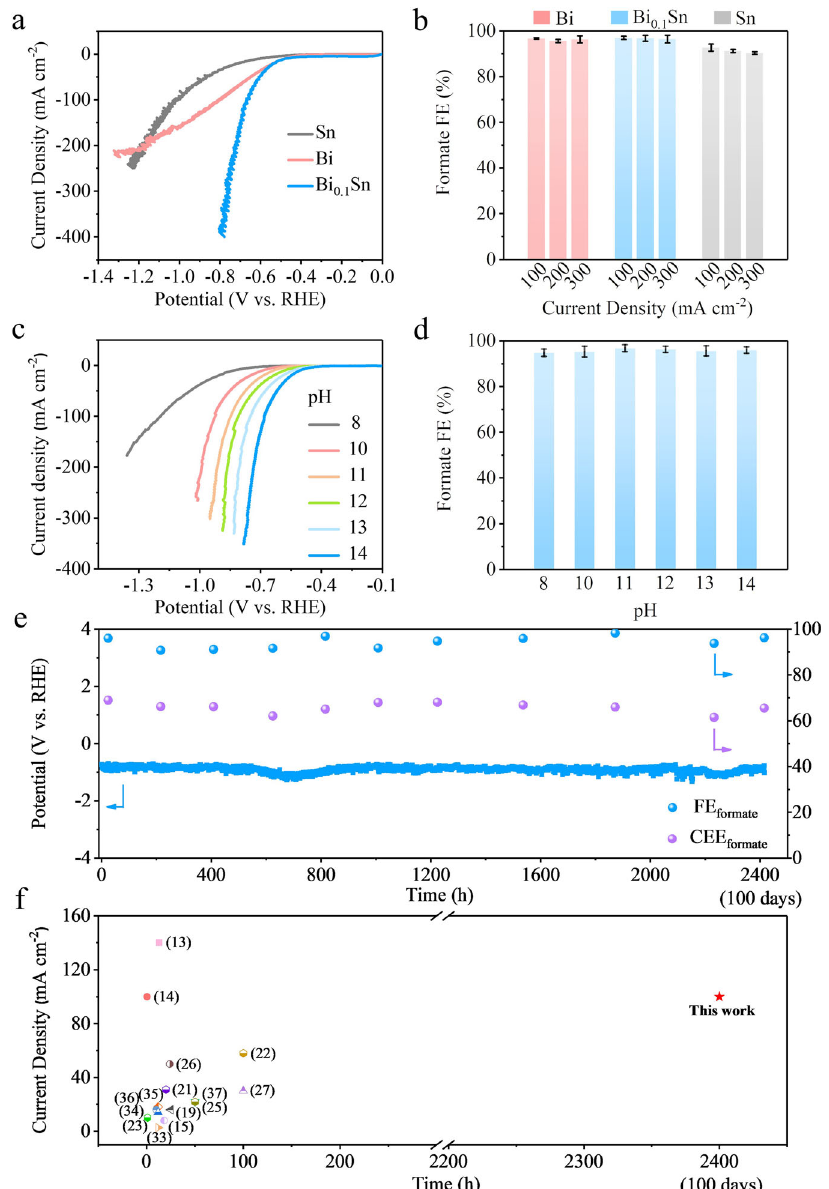
Fig. 3 CO2 electroreduction performance using Bi0.1Sn, Bi, and Sn catalysts. a Linear sweep voltammetry curves of Bi 0.1 Sn, Bi, and Sn in 1 M KOH electrolyte. b The corresponding formate FEs under different current densities. c Linear sweep voltammetry curves. d The corresponding formate FEs in 1 M KHCO 3 and KOH electrolytes at different pH (pH = 8, 10, 11, 12, 13, and 14) at a current density of 100mAcm − 2 . e The CO 2 -reduction chronopotentiometry curve (blue line), CO 2 -to-formate FE (blue dots), and CO 2 -to-formate half-cell energy conversion ef fi ciency (purple dots) in 1 M KHCO 3 and KOH electrolyte at pH = 11 at an applied current density of 100 mAcm − 2 . f Comparison of our work with previously published data. Error bars correspond to the standard deviation of fi ve independent